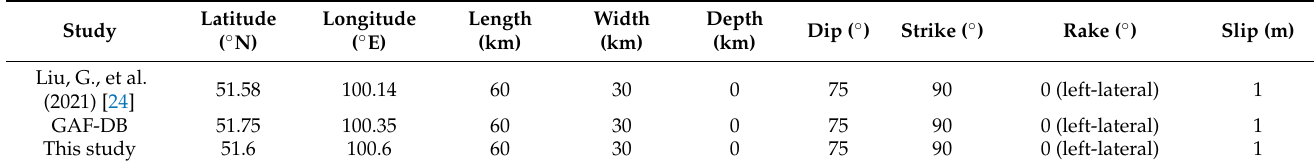
Table 4. Geometrical parameters of the Mondy Fault (MF) from different sources.